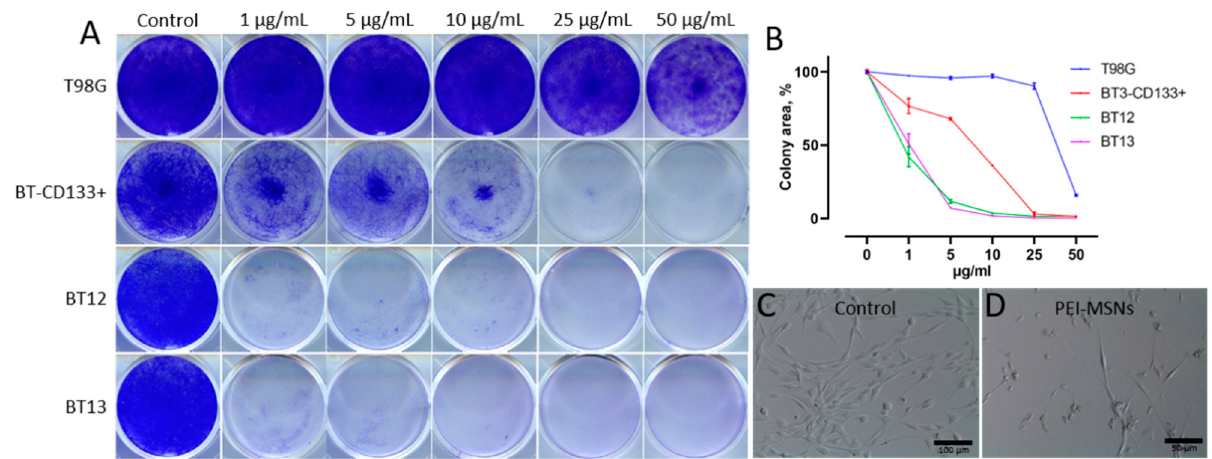
Figure 2. Death of patient-derived GSCs induced by PEI-MSNs. ( A ) Colony growth assay of T98G (GB cell line, cultured in standard conditions), BT-3-CD133 + , BT-12, and BT-13 (GSCs, cultured in stem cell conditions) cells treated with 1–50 µg/mL of PEI-MSNs. ( B ) Quantification of colony growth by using the “ColonyArea”. ( C , D ) Representative images of BT-3-CD133 + (cultured in stem cell conditions) cells without ( C ) or with ( D ) 10 µg/mL PEI-MSN treatment.